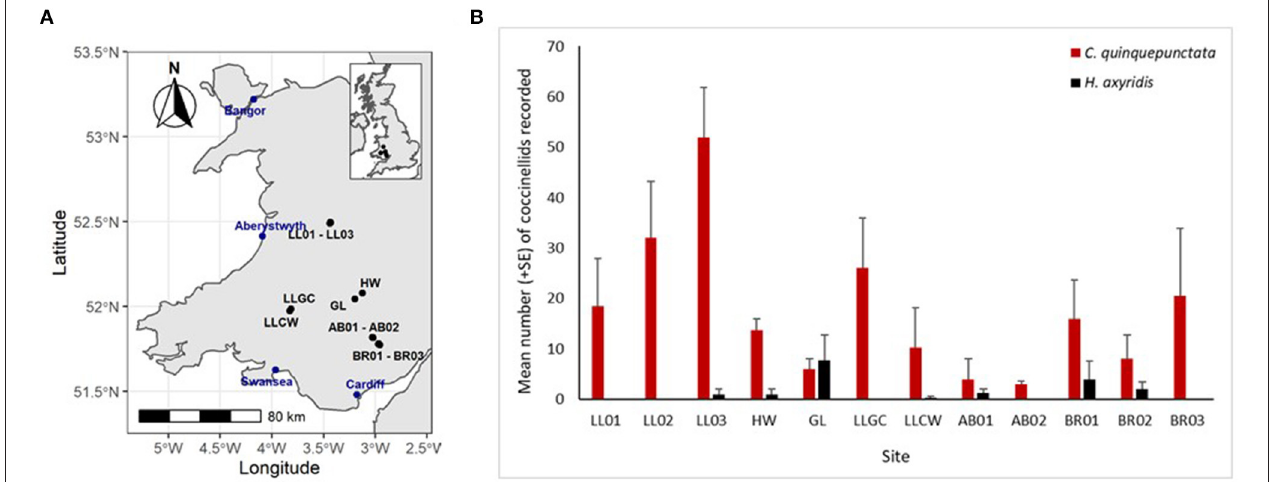
FIGURE 2 | (A,B) Map of survey sites along with mean number ( + SE) per site visit of Coccinella quinquepunctata and Harmonia axyridis recorded at each site from both survey methods combined in 2017. Sites: AB01 and AB02, Abergavenny site 1 and 2; BR01, BR02, and BR03, Bryn sites 1, 2, and 3; GL, Glasbury; HW, Hay-on-Wye; LL01, LL02, and LL03, Llandinam sites 1, 2 and 3; LLCW, Cwmgwyn Farm; LLGC, Llandovery.